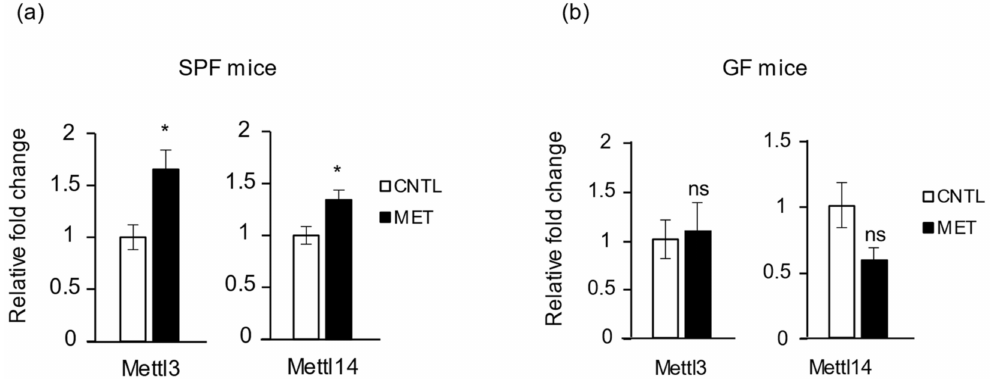
Figure 7. Metronidazole disrupts skeletal muscle RNA epigenetics. Real-time quantitative PCR analysis of RNA m 6 A methyltransferases Mettl3 and Mettl14 expression in gastrocnemius muscle of metronidazole-treated and nontreated ( a ) SPF and ( b ) GF mice. N = 5 mice per group. Data presented as means ± SEM. Asterisks indicate statistically significant differences (*, p < 0.05; ns, nonsignificant with student’s t